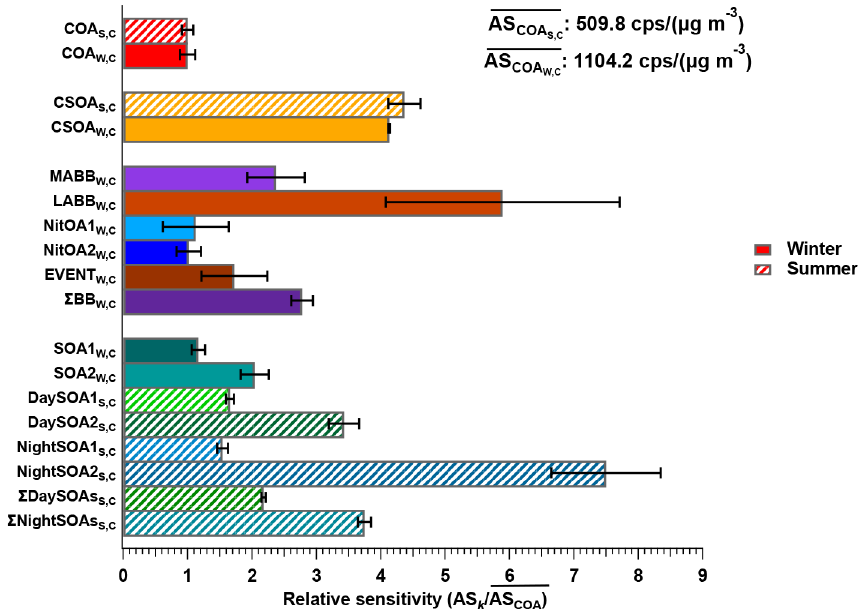
Figure 5. Comparison of AS k / AS COA of different factors resolved from the cPMF on the summer and winter datasets. Mean values are C shown as bars, and error bars indicate the standard deviation over all accepted bootstrap runs. The following factor aggregations are also shown: (cid:54) BB W , C = MABB W , C + LABB W , C + NitOA1 W , C + NitOA2 W , C + EVENT W , C . ; (cid:54) DaySOAs S , C = DaySOA1 S , C + DaySOA2 S , C ; and (cid:54) NightSOAs S , C = NightSOA1 S , C + NightSOA2 S , C .